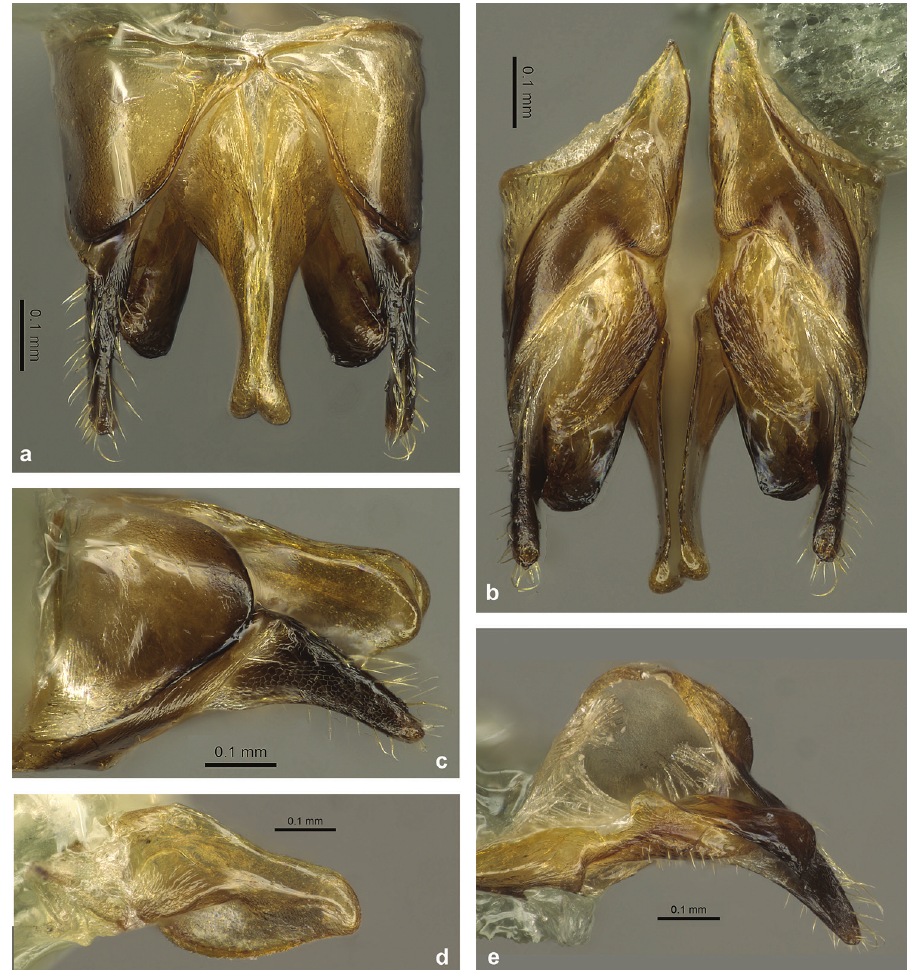
Figure 7. Genital structures of C. explodens sp. n. paratype, male; genital capsule in a dorsal b ventral, and c lateral view d left penis valve e right volsella and